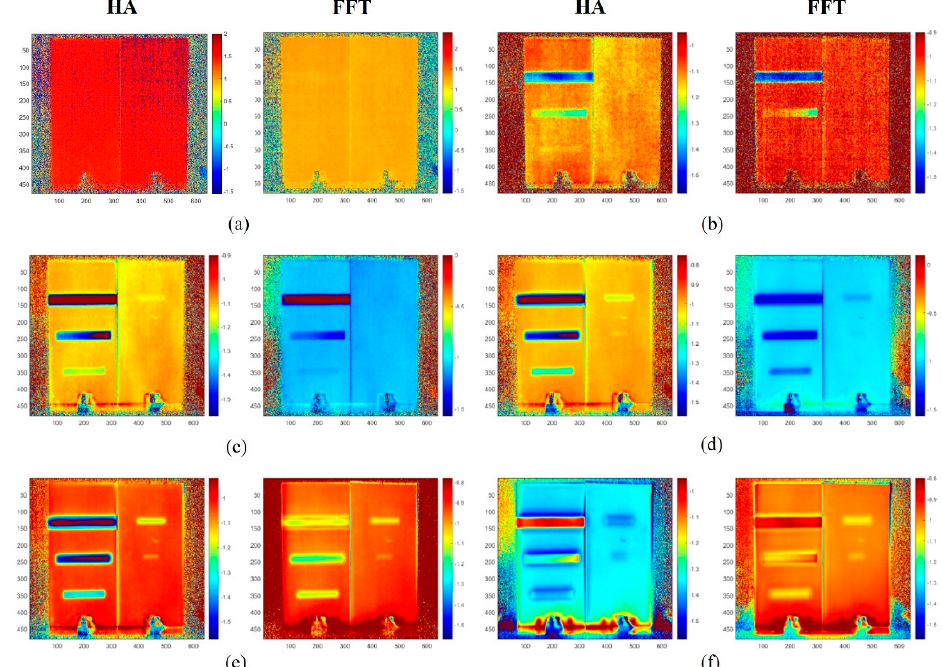
Figure 8. Processed images with HA and FFT algorithms for detecting defects in group 1 of samples at different modulation frequencies: ( a ) 1 Hz, ( b ) 0.2 Hz, ( c ) 0.1 Hz, ( d ) 0.05 Hz, ( e ) 0.03 Hz, and ( f ) 0.01 Hz.